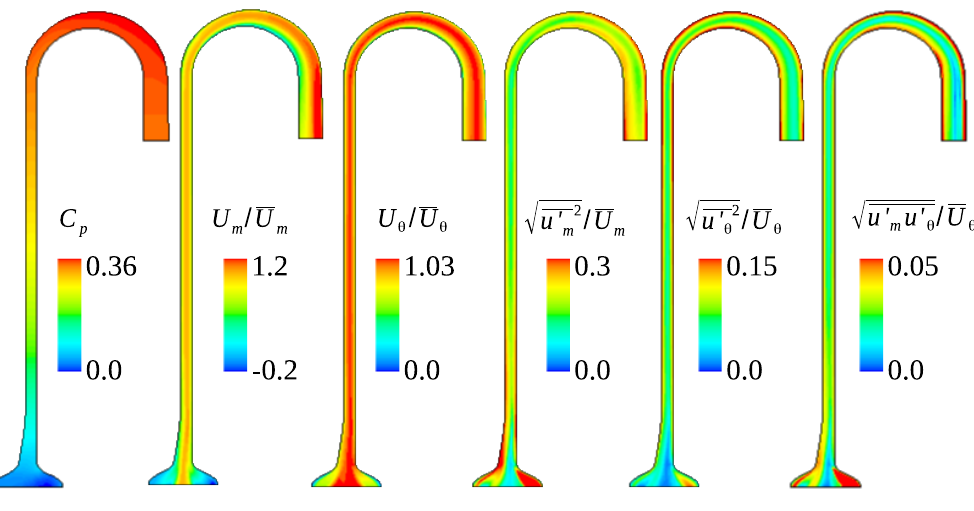
Figure 4. Time-averaged scalar contour distributions for α IN = 9.5 ◦ , colored on the side view. Flow quantities of interest are indicated in the text annotations.